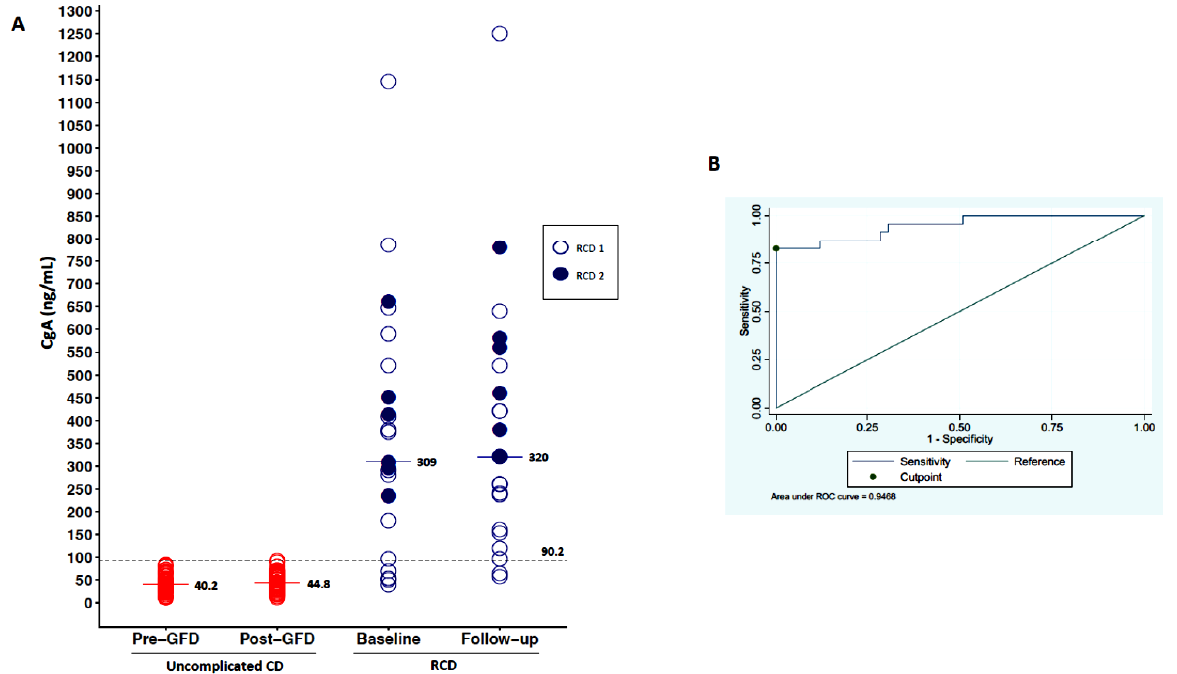
Figure 1. Variation of CgA levels. ( A ) shows the variability of CgA levels in the three groups of patients (uncomplicated CD, RCD type 1, RCD type 2) at baseline and at follow-up. Serum levels of CgA at baseline were higher in patients with RCD in comparison to uncomplicated CD patients before-GFD. ( B ) is an ROC curve that shows an empirical cut-off point of CgA (90.2 ng/mL), which is able to differentiate uncomplicated CD vs. RCD patients, with a sensitivity of 83% and a specificity of 100%.